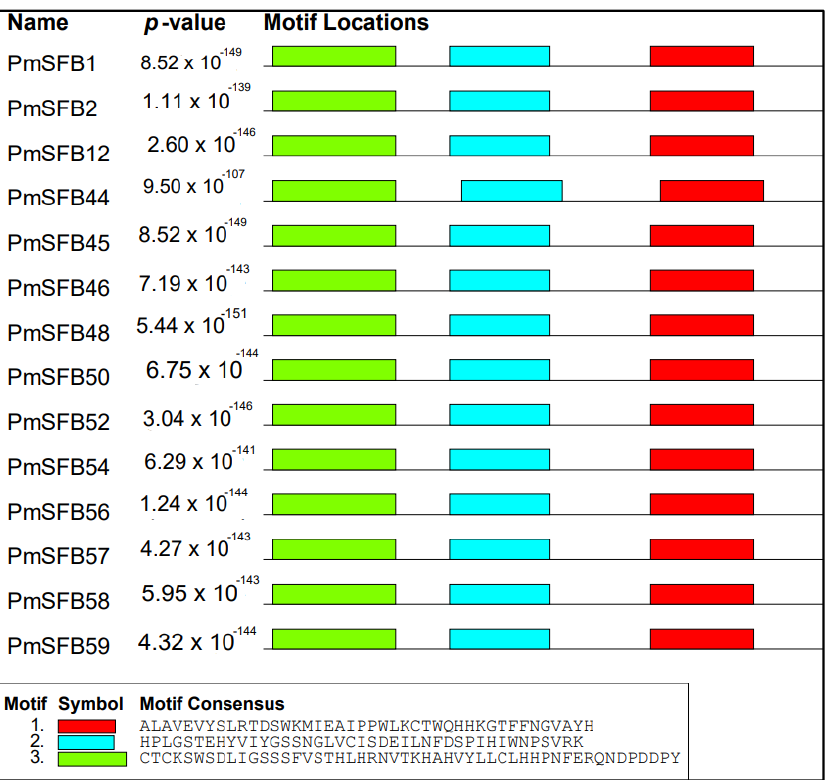
Figure 4. Motif distribution of SFB proteins in Japanese apricot. Each motif is denoted by a number in the colored box.